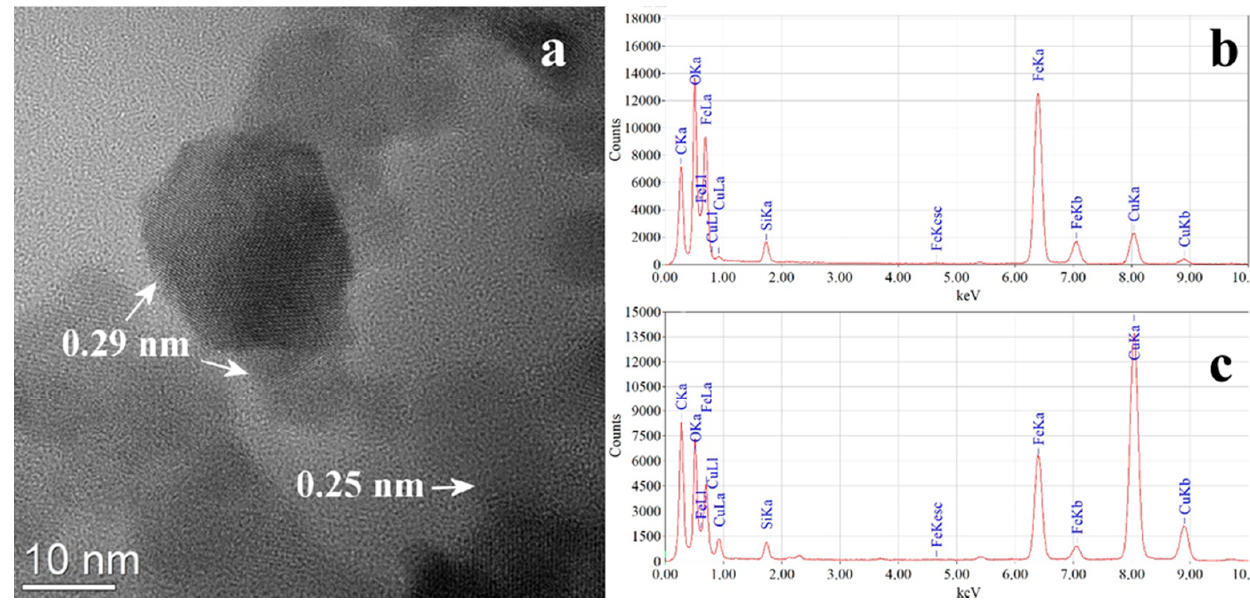
Figure 5. HR (high resolution) TEM Imageof NPs functionalized with TPPS ( a ) and EDS spectra for synthesized NPs ( b ), and NPs functionalized with TPPS ( c ).